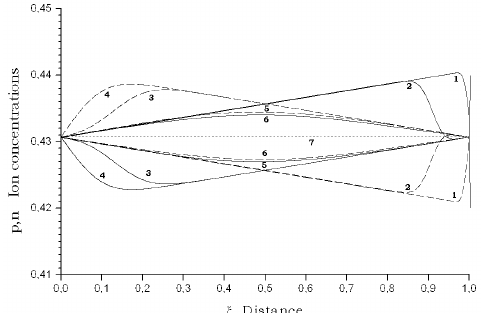
Figure 2. Current density J = J ( ξ ) at the electrode surface. Electroneutral bulk.